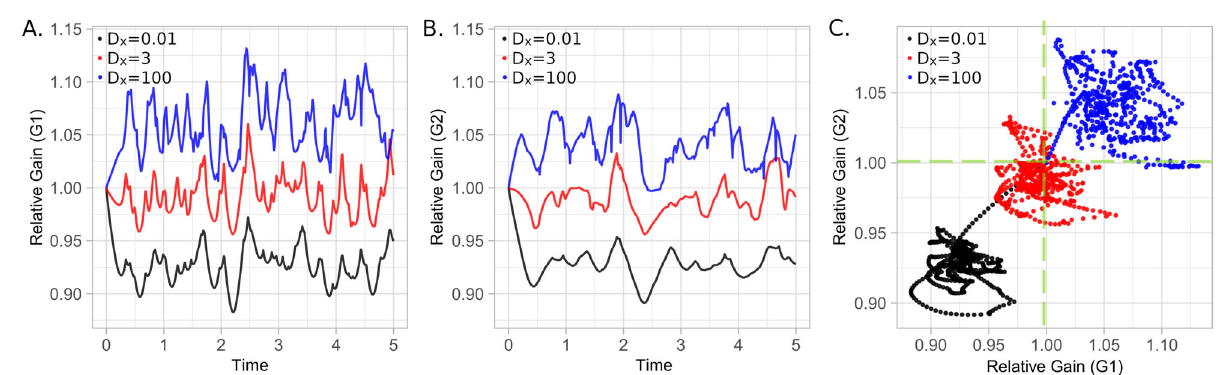
Fig.5|TimeevolutionofarandomexperimentforKuramoto ’ smodel(Eq.1)on the multiplex system of Fig. 4A in which, initially, all oscillators are in phase ( θ i =0) having their fundamental frequencies chosen from a uniform dis- tribution [0,1] for different coupling constants D x . A , B Shows the evolution of